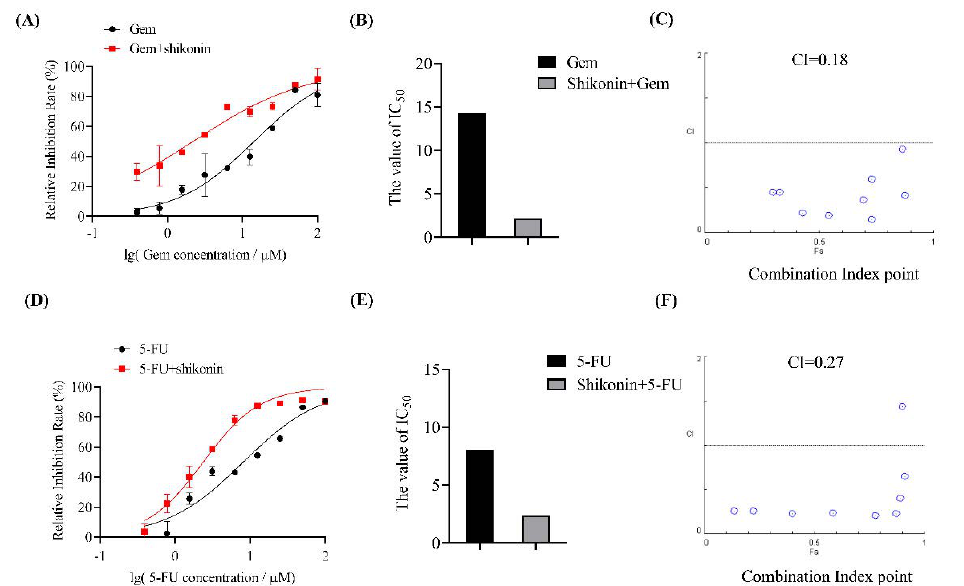
Figure 6. Combination of shikonin and chemotherapeutic agents showed significant synergistic effects against pancreatic cancer cells. ( A ) BxPC − 3 cells were treated with Gem with or without shikonin and analyzed using MTT assay. ( B ) IC 50 values of Gem or Gem plus shikonin in BxPC − 3 cells. ( C ) CI of Gem plus shikonin in BxPC − 3 cells. ( D ) MTT assay of BxPC − 3 cells treated with 5 − FU with or without shikonin. ( E ) IC 50 values of 5 − FU with or without shikonin in BxPC − 3 cells. ( F ) CI of 5 − FU and shikonin in BxPC − 3 cells. Results are means ± SD of three independent experiments.